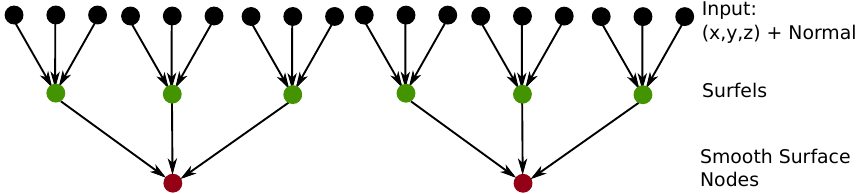
Figure 1: The hierarchical processing architecture. The inputs (3D points + normals) in a local neighbourhood are used to estimate the parameters of a larger planar patch, the surfels, which model the implicit